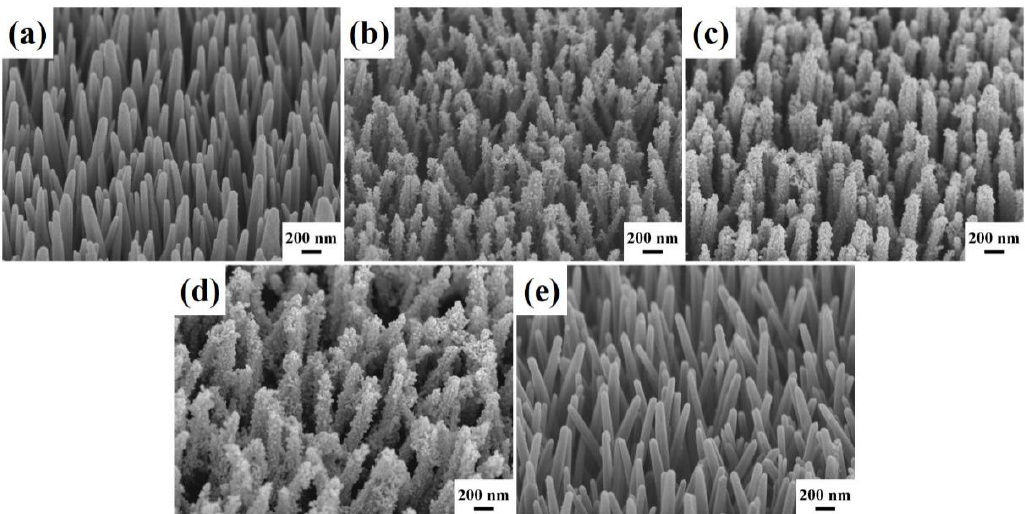
Figure 1. The tilt-view FESEM images of ( a ) Er-doped ZnO nanowires and ( b – e ) Er-doped ZnO/CuS core-shell nanowires with different concentrations of CuS precursor fabricated on the glass substrates. The concentrations of CuS precursor were ( b ) 2.5, ( c ) 5, ( d ) 10, and ( e ) 20 mM, respectively.